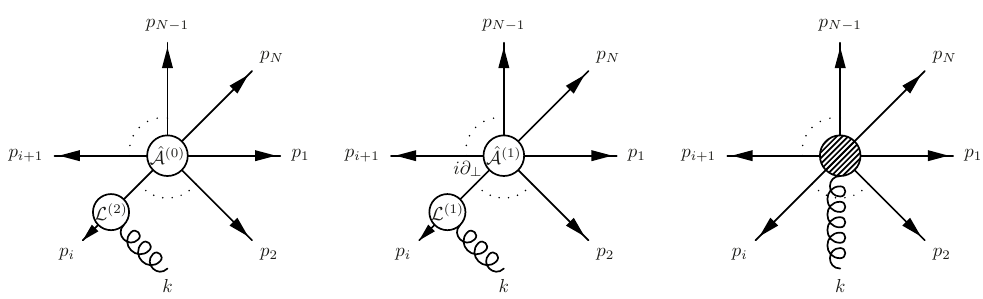
Figure 2 . Three possible contributions to the radiative amplitude in SCET at NLP. The first diagram represents the time-ordered product of the leading power current and the λ 2 suppressed Lagrangian. In the second diagram, both current and Lagrangian are suppressed by a single power of λ . There are no soft building blocks at order λ 2 ; hence, the third diagram does not contribute to the LBK amplitude in SCET. The leading-power emission would correspond to the first diagram with an L (0)